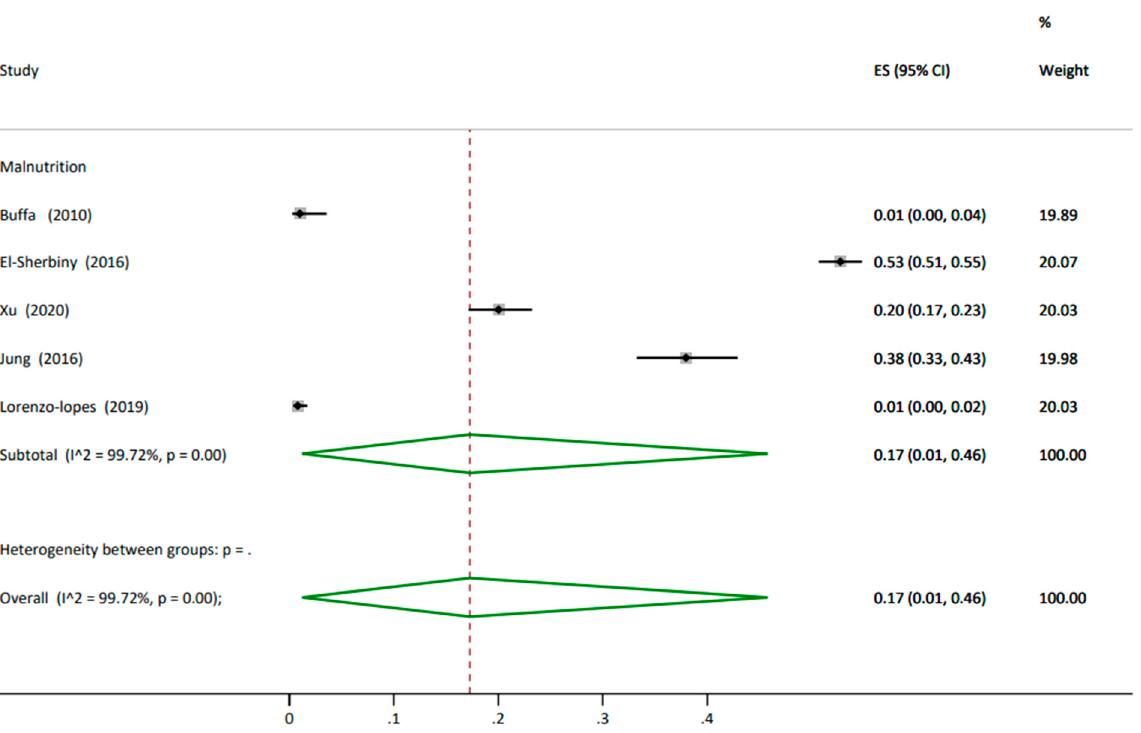
Figure 2. Prevalence of undernutrition in the older people living in the community. ES: effect size; CI: confidence interval. Table 2. Prevalence in studies of older people with undernutrition, frailty, or sarcopenia.